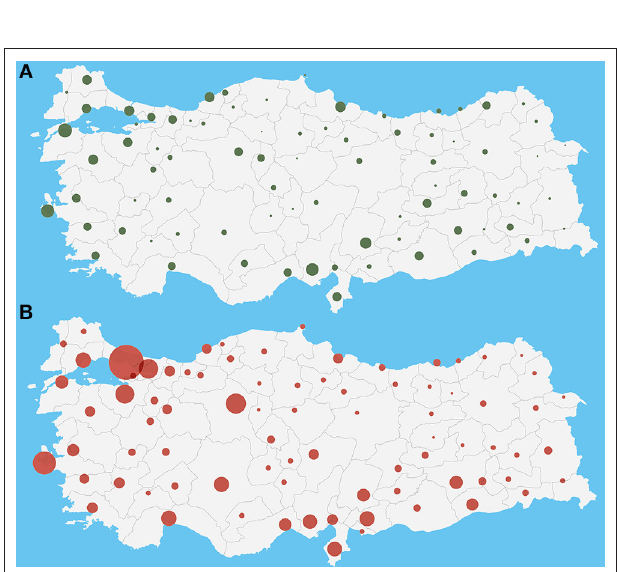
FIGURE 13 | (A) Distribution of electricity generation in cities in 2016 (GWh) Source: Own elaboration using data from Enerji Atlasi (B) 19 Distribution of electricity consumption in cities in 2015 (GWh) Source: Own elaboration using data from TURKSTAT 20